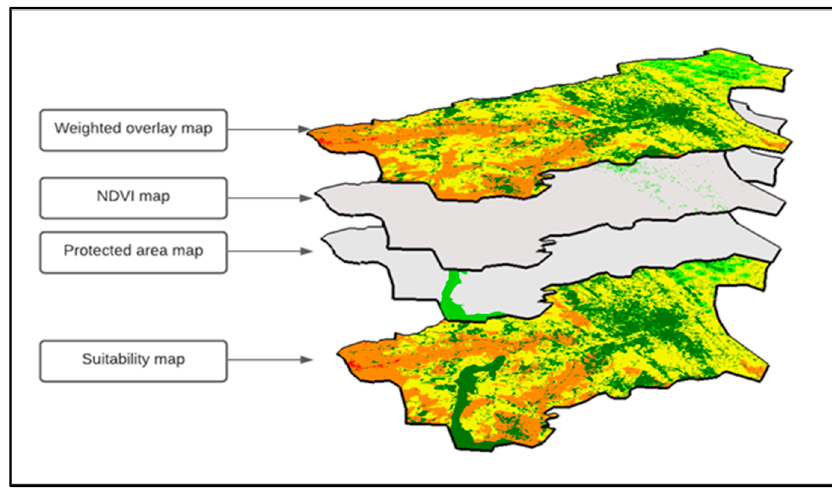
Figure 7. Excluding areas from the weighted overlay map to create the suitability map.